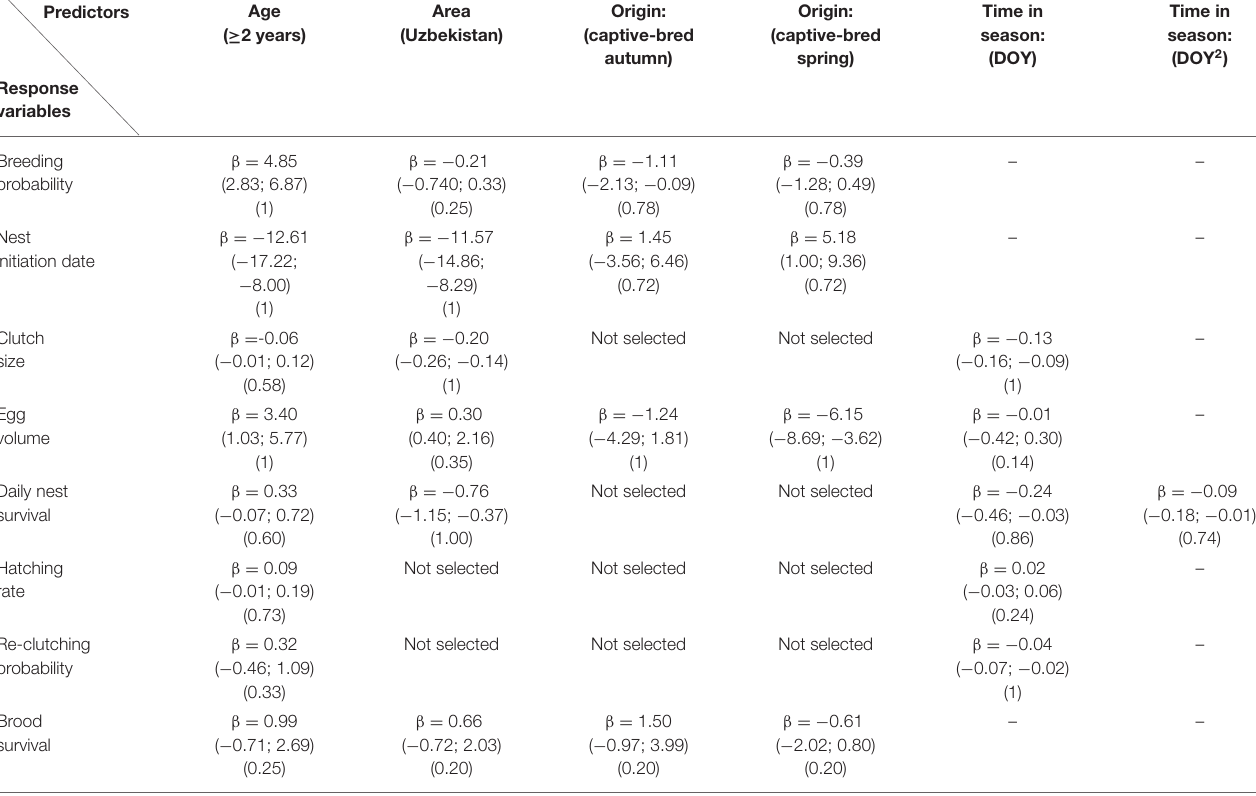
TABLE 2 | Estimated beta coefficients ( β ) ( ± 95% CIs) and relative variable importance (RVI) for variables selected in the best models ( 1 AIC c ≤ 2) with respect to breeding parameters of migrant Asian houbara ( Chlamydotis macqueenii ) in Central Asia. Predictors